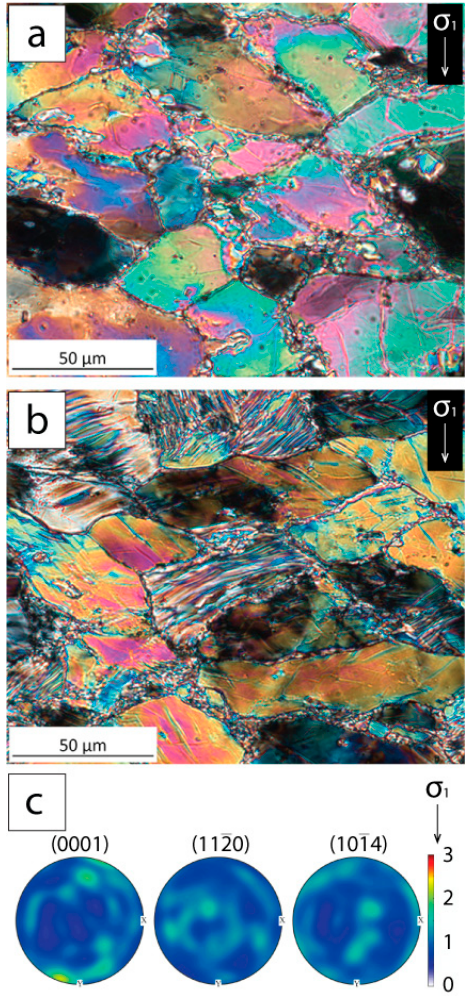
Figure 8. Microstructures in coarse-grained magnesite cylinders deformed at T = 900 ◦ C in the DDIA ( a ) include flattened relict grains, recrystallized grains at relict grain boundaries, undulatory extinction and few kinks (Photomicrograph, MAG_014, T = 900 °C, P eff = 2.9 GPa, 𝜀(cid:4662) = 3.5 × 10 − 5 ·s − 1 , σ diff = 0.8 GPa). ( b ) At higher pressures ( P eff > 6 GPa) most grains of deformed coarse magnesite areheavily kinked (photomicrograph, MAG_010, T = 900 ◦ C, P e ff = 7.5 GPa,